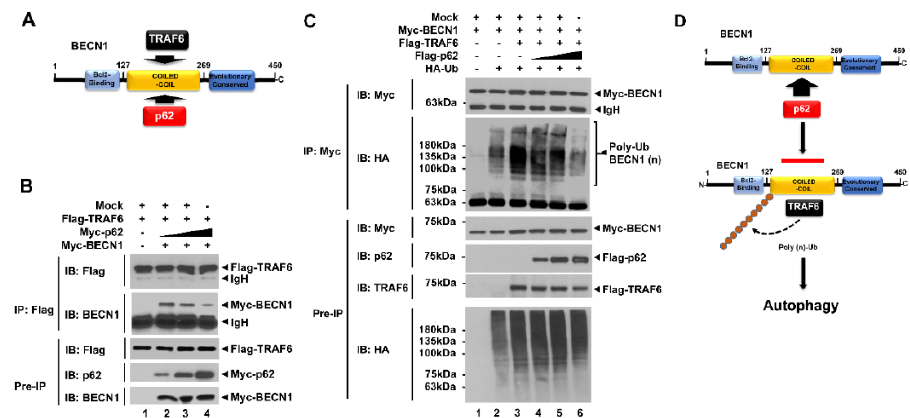
Figure 2. p62 interrupts the association of TNF (Tumor necrosis factor) receptor-associated factor 6 (TRAF6)-BECN1 complex and inhibits the ubiquitination of BECN1. ( A ) TRAF6 and p62 interact with the coiled-coil domain of BECN1. ( B ) HEK293T cells were transfected with mock vector, Flag-tagged TRAF6, and Myc-tagged BECN1, along with different concentrations of Myc-tagged p62, as indicated. Transfected cells were harvested, and cell lysates were immunoprecipitated with anti-Flag antibody and probed with anti-Flag, anti-p62, or anti-BECN1 antibody. ( C ) HEK293T cells were transfected with mock vector, Myc-tagged BECN1, Flag-tagged TRAF6, and HA-tagged Ub, along with different concentrations of Flag-tagged p62, as indicated. Transfected cells were harvested, and cell lysates were immunoprecipitated with anti-Myc antibody and probed with anti-Myc, anti-HA, anti-p62, or anti-TRAF6 antibody. ( D ) A schematic model for how p62 interrupts the association of TRAF6-BECN1 complex and inhibits the ubiquitination of BECN1. TRAF6 interacts with the coiled-coil domain of BECN1 and induces the ubiquitination of BECN1, leading to autophagy activation. Simultaneously, p62 can interact with the coiled-coil domain of BECN1, and that inhibits the interaction of TRAF6 to BECN1 and the ubiquitination of BECN1.